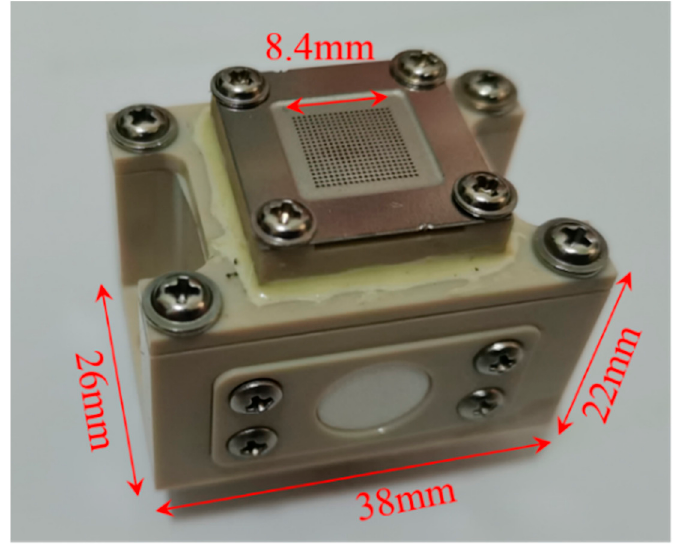
Figure 9. Image of an ILET, showing the complete thruster.